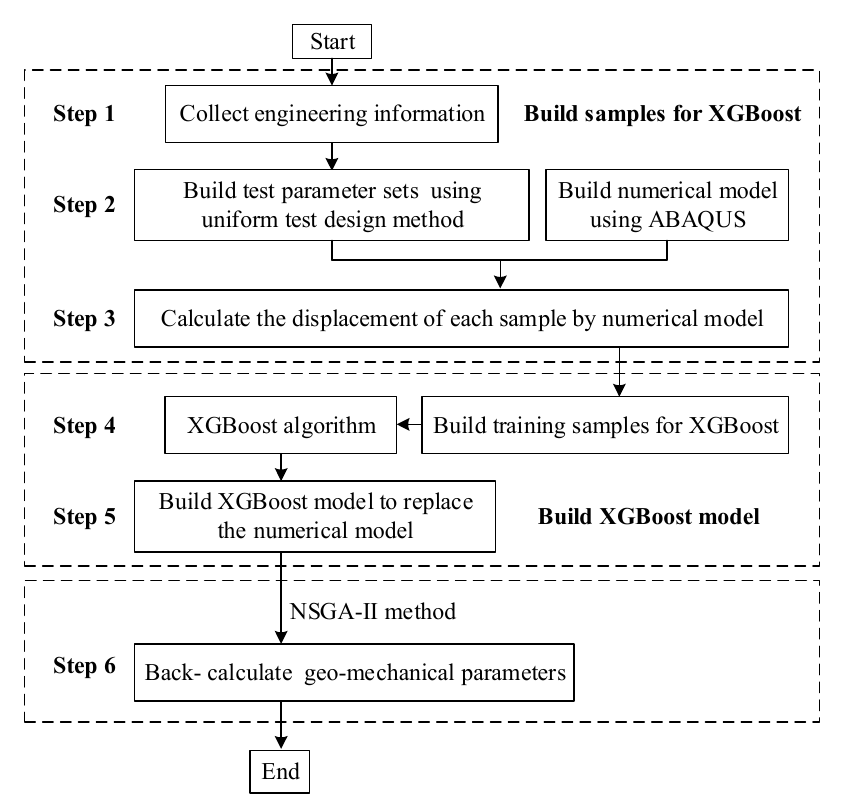
Figure 3. Flowchart of XGBoost–NSGA-II-based back analysis.